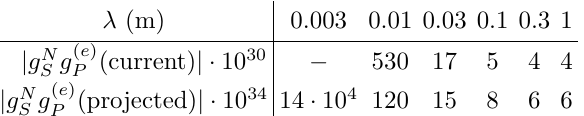
Table 13 . The current [135] and projected limits [134] on the strength of the axion mediated monopole-dipole interaction from the